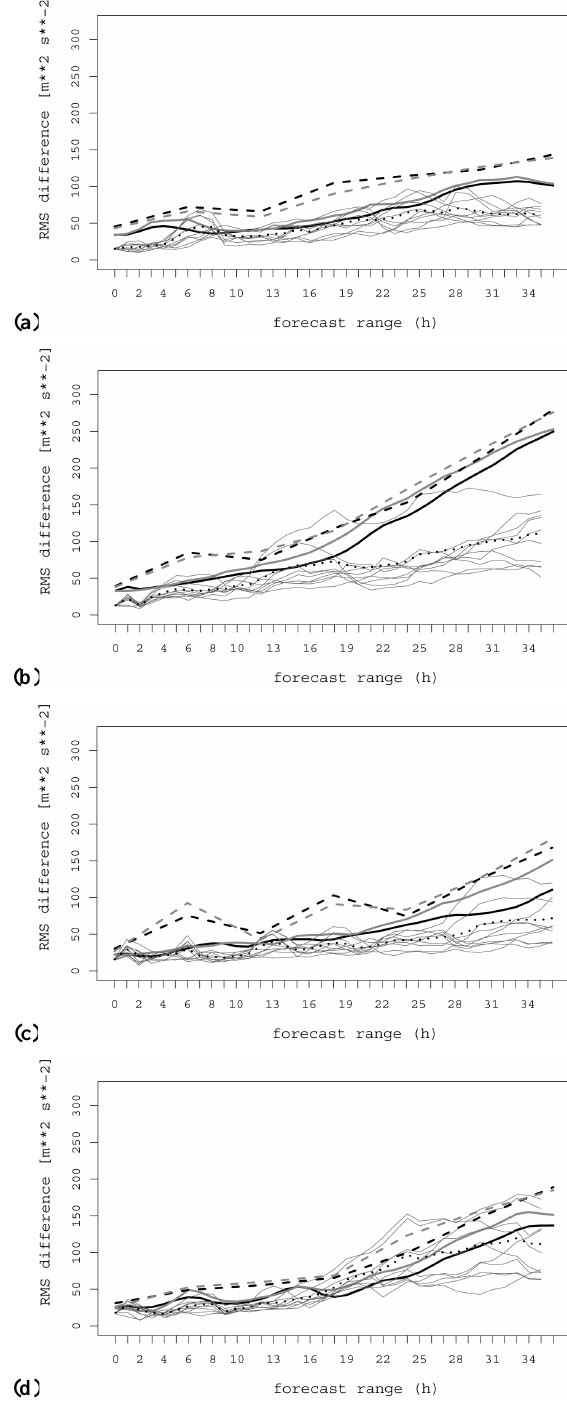
Fig. 3. RMS differences between pairs of correspondent members (thin solid), average RMS difference between all pairs (thick dot- ted), RMS spread (thick solid) and RMSE of the ensemble mean (thick dashed), as a function of the forecast range. RMS spread and error lines are black for COSMO-H2-EPS and grey for EXP- H2-EPS. Plots are relative to four cases only: 2012092512 (a) , 2012101412 (b) , 2012102512 (c) , and 2012103012 (d)